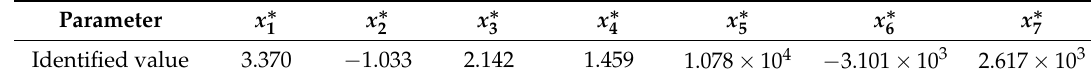
Table 5. The identified value of the parameter vector x ∗ during charge.